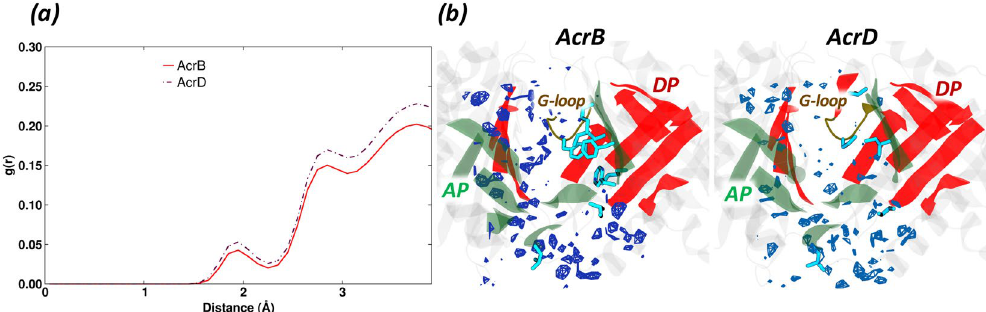
Figure 5. Hydration of AP in the Loose protomer of AcrB and AcrD. ( a ) Comparison of RDF profiles of water oxygen atoms around AP (all atoms) in the Loose protomer of AcrB (red solid line) and AcrD (brown dash- dotted line) extracted from the equilibrium MD trajectories. ( b ) Comparison of SDF of waters within the AP of Loose protomer. The SDF was calculated over the configurations forming the most populated cluster of AcrB (left) and AcrD (right). The isosurfaces are shown at density isovalue of 6, meaning that the represented surfaces correspond to 6 times higher average number density of solvent molecules than bulk (see Subsection Hydration in Methods). The AP and DP are marked in green and red while the G-loop in yellow cartoon representations. The hydrophobic/aromatic residues of the pocket are shown as cyan sticks in the respective